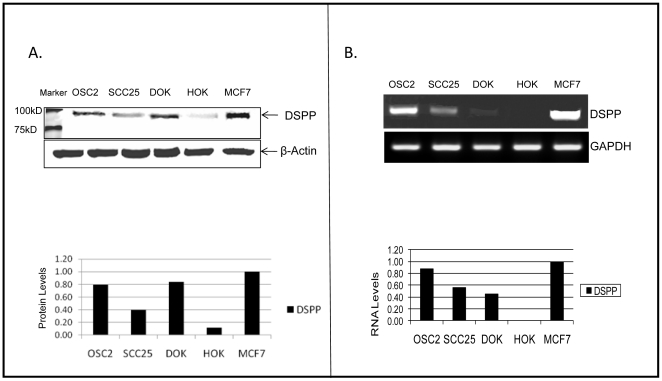
DSPP upregulation in oral-cancer cells, OSC2 and SCC25, and the dysplastic oral keratinocyte cells, DOK.(A) Western blot (WB) and densitometric analyses show significant upregulation of DSPP in OSC2, SCC25, and DOK cells compared with HOK negative controls. There is a basal (<10%) level of DSPP expression in primary HOK cells. MCF7 cell line known to express DSPP was used as positive control. Normalization was with β-actin. (B) Semiquantitative RT-PCR analysis shows DSPP-mRNA expression in OSC2, SCC25, and DOK cells consistent with WB results in (A) with undetectable DSPP-mRNA levels in HOK cell. Normalization was with GAPDH. Cells used in study: OSC2, a human OSCC cell line derived from regional cervical lymph node metastasis of a primary human tongue squamous cell carcinoma; SCC25, a primary tongue squamous cell carcinoma; DOK, a human oral epithelial dysplastic cell line derived from dorsal tongue; and MCF7 (acronym of Michigan Cancer Foundation – 7), a human breast cancer cell line isolated from a 69-year-old Caucasian female.